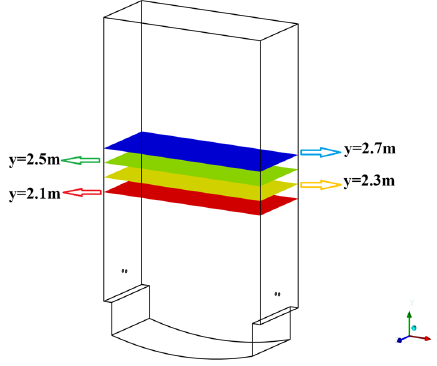
Figure 6. Schematic diagram of four sections.